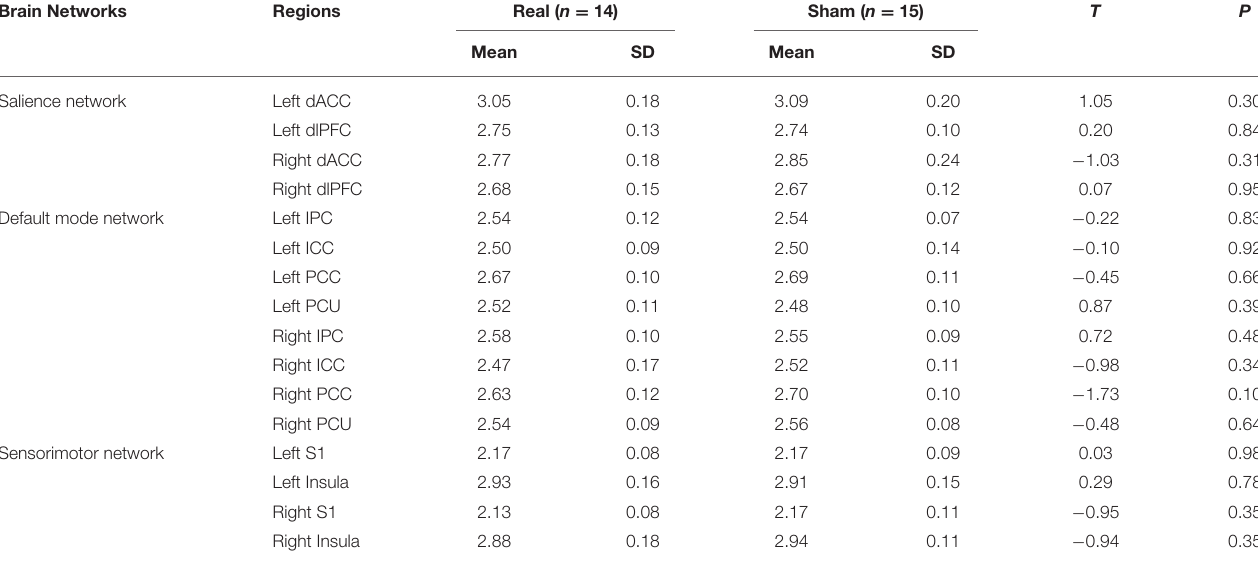
TABLE 2 | The SUVR in all selected regions of each group. Brain Networks